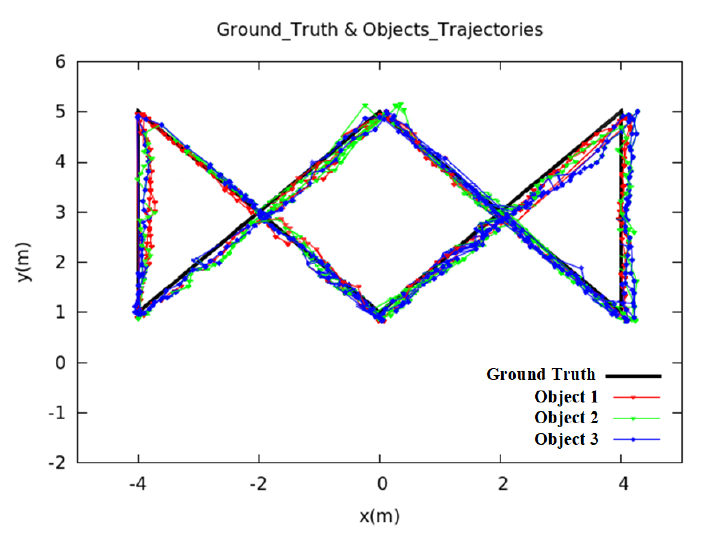
Figure 9. Experimental results of complex path in indoor environment. Table 7. Comparison of experimental results of complex path in indoor environment based on different